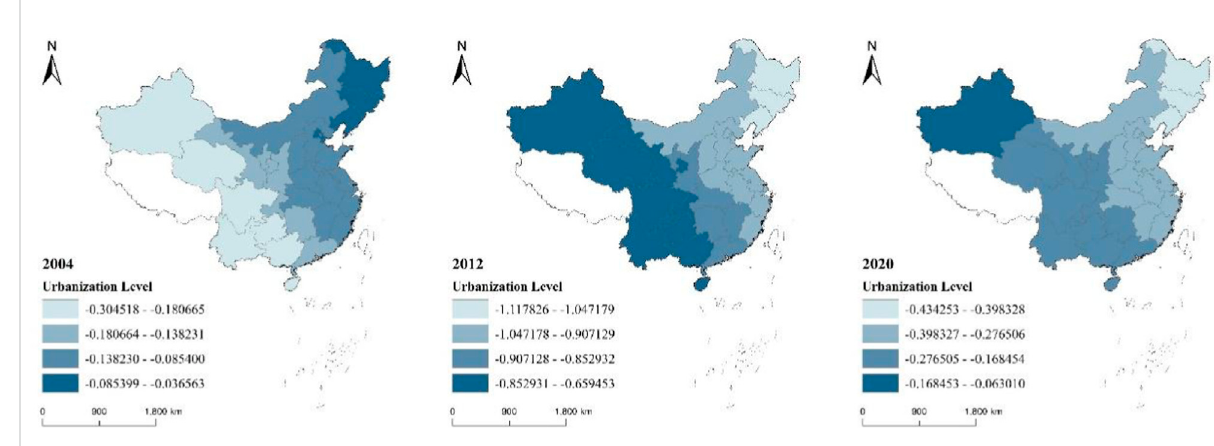
FIGURE 6 Regression coef fi cients for urbanization levels.